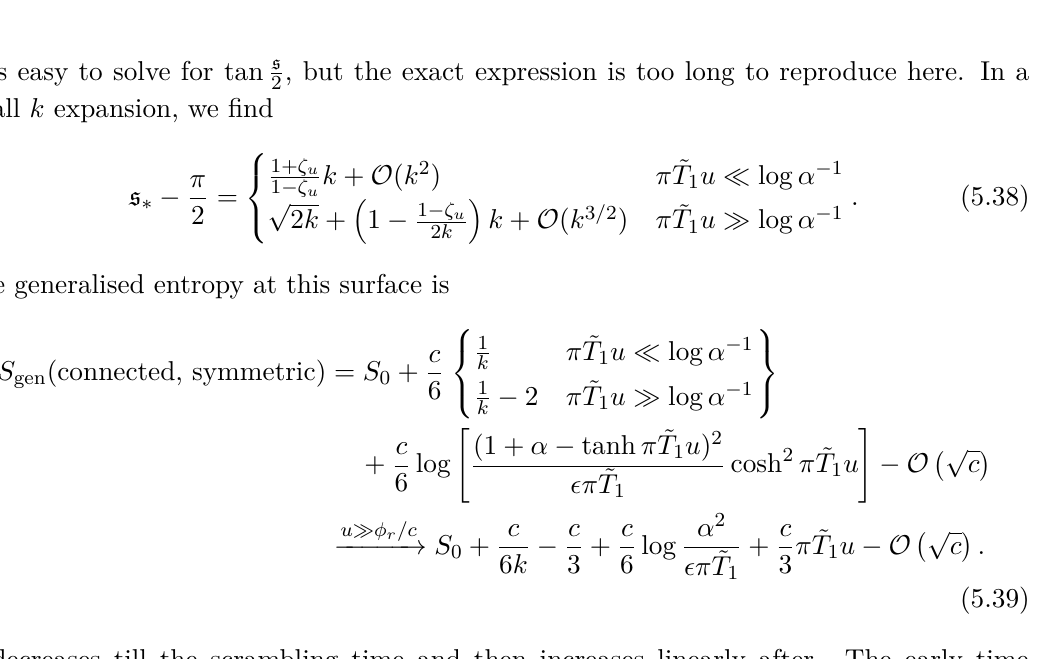
Figure 15. A simple quasiparticle explanation for the early-time decrease in the generalised entropy. The regions bounded by solid green lines are the quantum extremal wedges at the two times. The arrows are mirror quasi-particles that are entangled in the eternal black hole; as time goes on, more and more entangled pairs end up on the same side and the entanglement decreases. The turn-around at scrambling time is not so easily